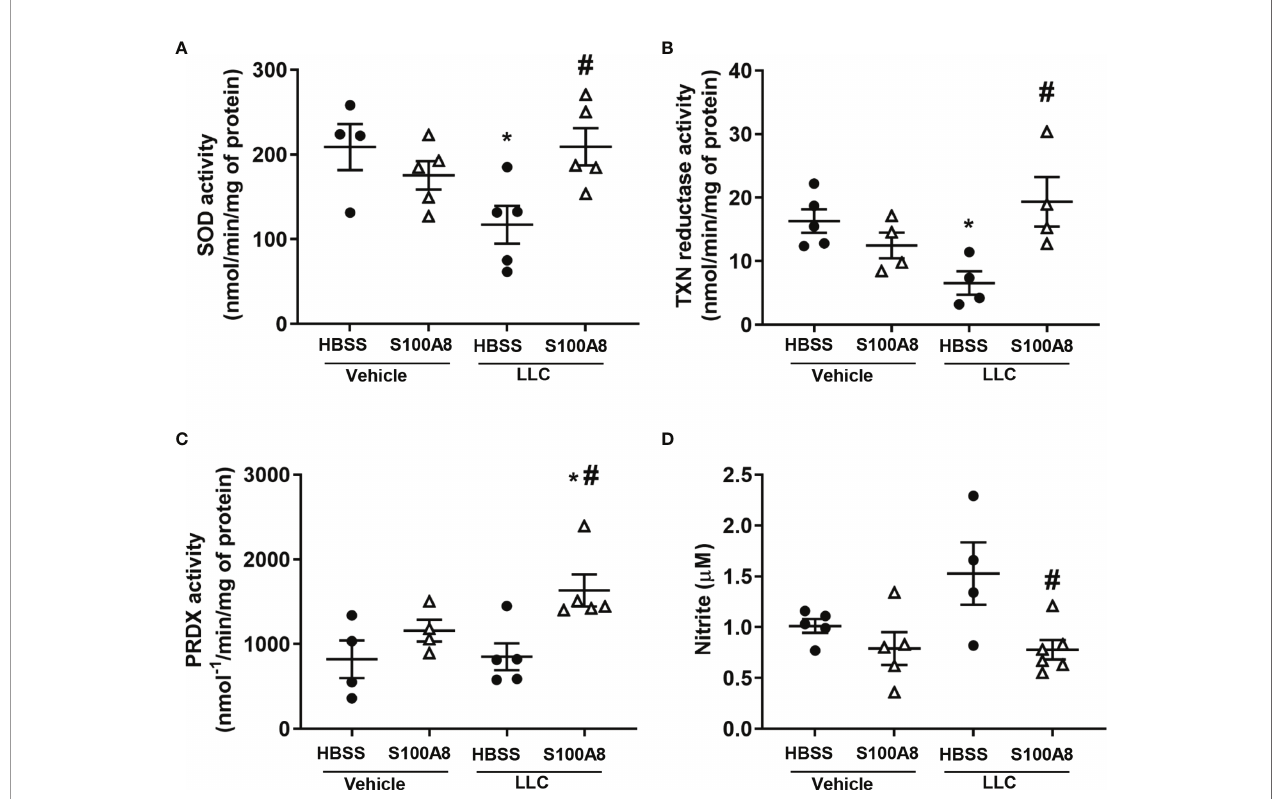
FIGURE 4 | Inhalation of S100A8 induced antioxidant enzyme activity and reduced nitrite production in lungs from mice with orthotopic lung tumors. (A – C) Graphs showing enzymatic activities (means ± SEM) of SOD (nmol/min/mg of protein) (A) , TXN reductase (nmol/min/mg of protein) (B) and peroxiredoxin (PRDX) (nmol -1 / min/mg of protein) (C) in whole lungs collected from mice treated with recombinant S100A8 on Days 3, 6 and 9 post-LLC cell implantation and harvested on Day 10. Mice treated with HBSS served as controls, n = 4-6 mice per treatment group. (D) Graph demonstrating mean concentrations of nitrite ± SEM (µM) in bronchoalveolar lavage fl uid collected from mice treated with S100A8 on Days 3, 6 and 9 post-LLC cell implantation and harvested on Day 10. Mice treated with HBSS served as controls, n = 4-6 mice per treatment group. *p < 0.05 compared to HBSS + vehicle; # p < 0.05 compared to HBSS +